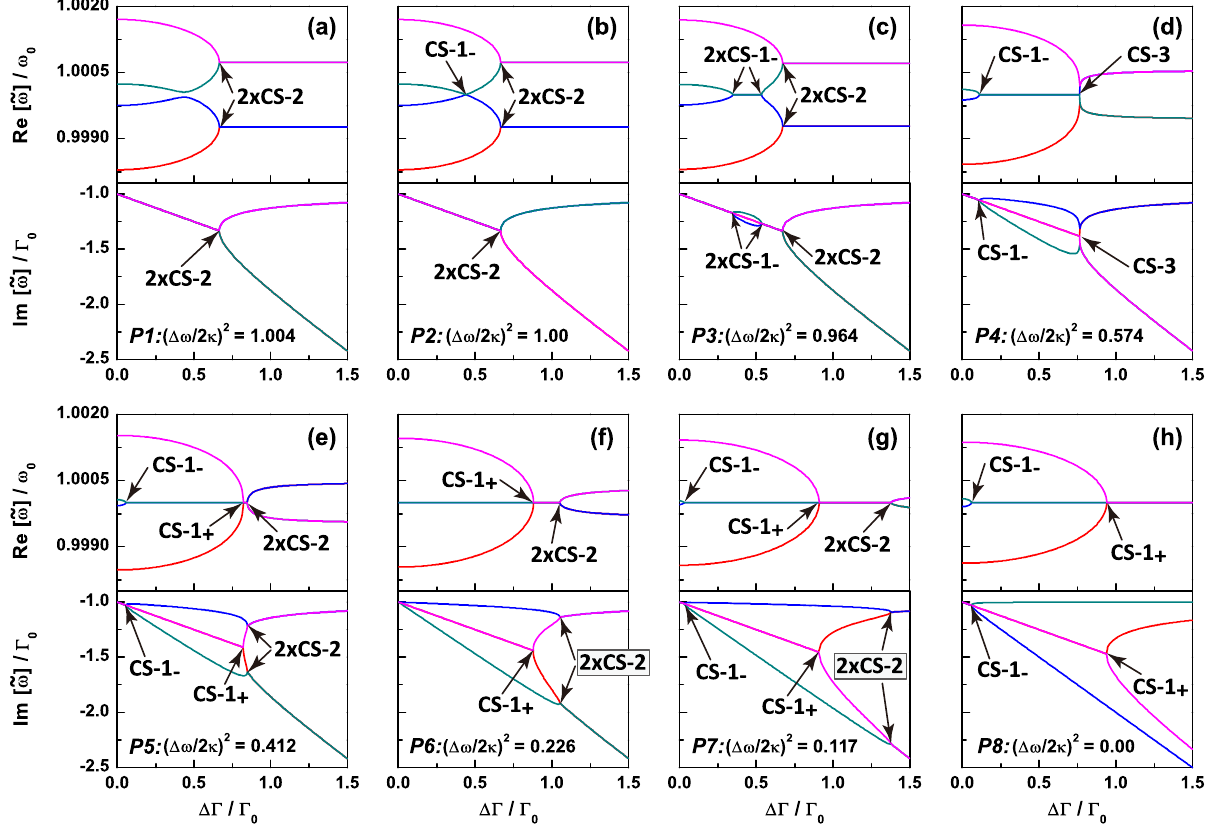
FIG. 3. Real and imaginary parts of eigenfrequencies as functions of asymmetric loss ΔΓ = Γ 0 for points P 1 to P 8 in the phase diagram shown in Fig. 2(b) are plotted from (a) to (h) accordingly. The system parameters are ω 0 ¼ 3427 . 59 rad = s, κ ¼ − 2 . 5 rad = s, t ¼ − 2 . 2 rad = s, and Γ 10 rad = s. Each exceptional point is labeled to show its types according to the main 0 ¼